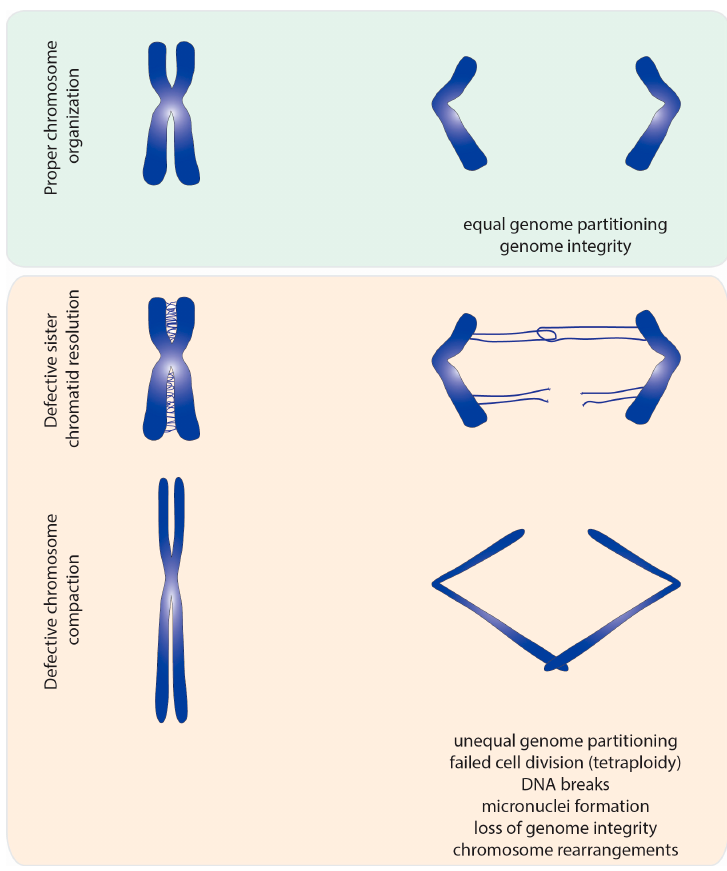
Figure 2. Segregation errors observed upon topoisomerase II malfunction. Impairment of topoisomerase II function results in lack of sister chromatid resolution and insufficiently compacted chromatin. In normal mitosis, sister chromatid intertwines are almost fully resolved at metaphase to ensure faithful genome segregation. Lack of topoisomerase II results in extensive entanglements between sister chromatids that persist during anaphase. Such entangled DNA threads not only hinder equal chromosome segregation, but may also lead to generation of breaks in DNA. In addition, chromosomes deprived of topoisomerase II display lowered levels of compaction. Under-compacted chromosomes are also prone to segregation errors during anaphase and cytokinesis, as the cleavage furrow may trap long and missegregated chromatids.